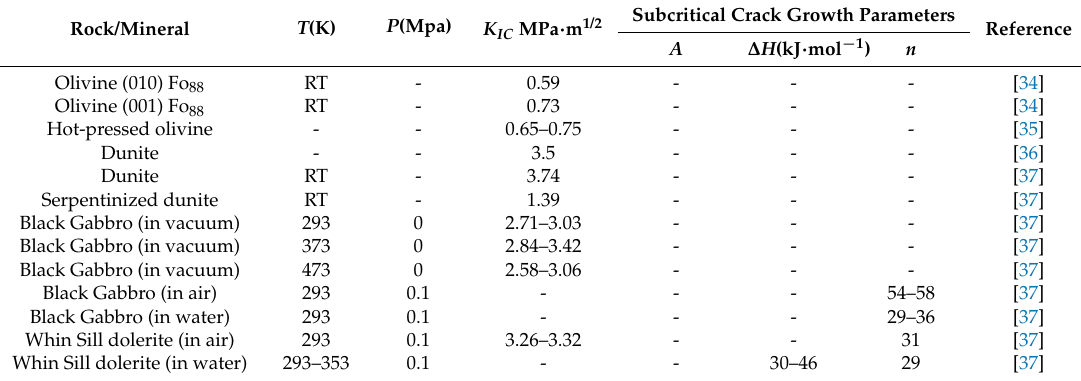
Table 2. Literature data on fracture toughness K IC and subcritical crack growth parameters A , ∆ H and n for various mafic and ultramafic rocks. T and P are the temperature and pressure at which measurements were made (RT is room temperature). Presumably, unspecified temperatures are room temperature, and unspecified pressures are atmospheric